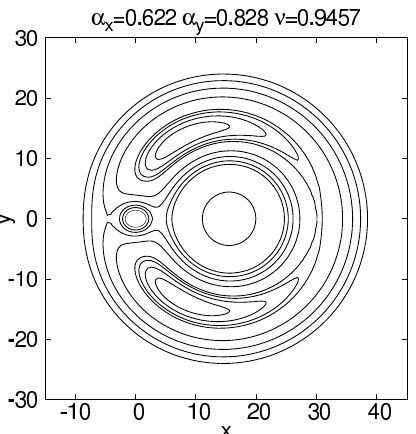
Fig. 2. Zero velocity curves and equilibrium points for the binary (66391) 1999 KW4 modeled as a small elongated body and a massive